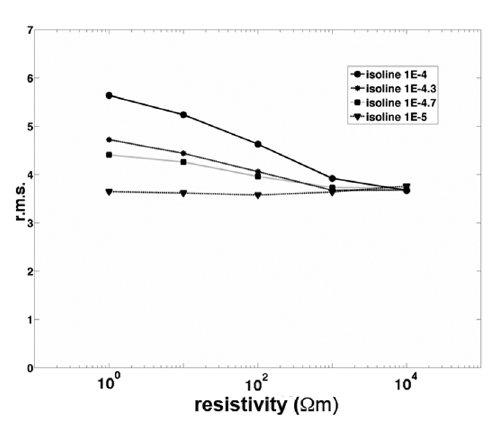
Fig. 10. Analysis of the resolved part of the model of fig. 6. The rms are obtained imposing constant values of resistivity below a chosen isoline of the sensitivity in the model of fig. 6. Isolines above 10 -5 show some variation of the relative rms, while below 10 -5 the rms remains quite constant, showing that the relative part of the model was not well resolved.